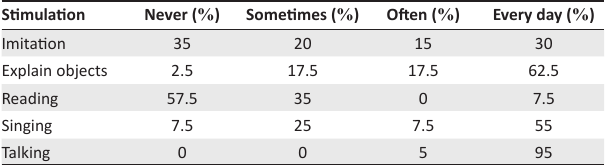
TABLE 4: Frequency of stimulation at home.